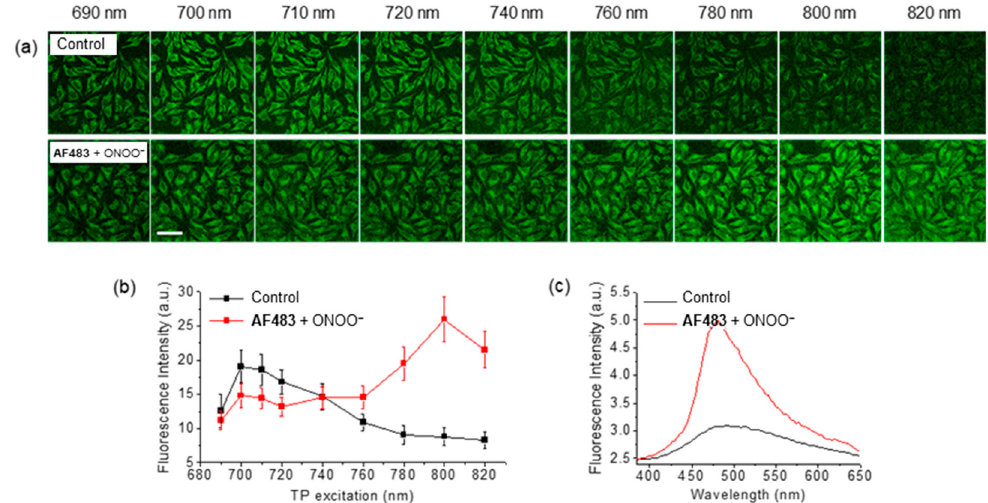
Figure 18. ( a ) Two-photon excitation of HeLa cells stained with AzuFluor ® 483-Bpin (5 µM) with (lower) or without (control, upper) pre-treatment of exogenous ONOO − (100 µM). Wavelengths shown are excitation wavelengths. Incubation time was 30 min. Images were obtained at 400–600 nm emission windows. Scale bar = 50 µm. ( b ) Average fluorescence intensities at various excitation wavelengths. ( c ) Fluorescence emission spectrum of AzuFluor ® 483-Bpin and AzuFluor ® 483-Bpin + ONOO − at λ ex = 800 nm excitation, taken from the corresponding cell image. Figure reproduced from ref. [89]. AF483 = AzuFluor ® 483-Bpin .